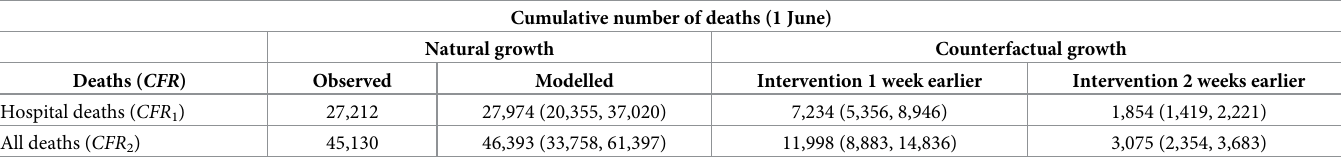
Table 3. Total number of COVID-19 deaths for three simulated